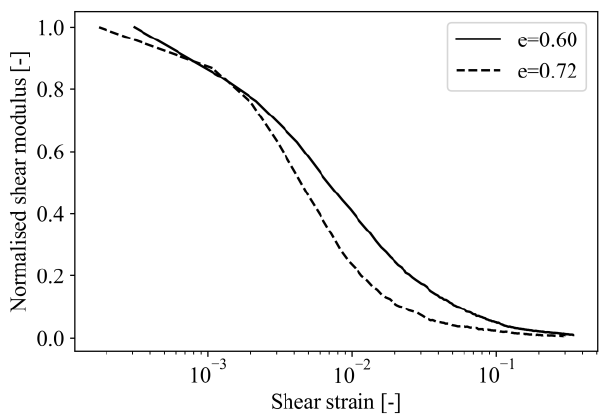
Figure 4. Shear modulus degradation during monotonic drained triaxial tests for loose and medium- dense packing. dense